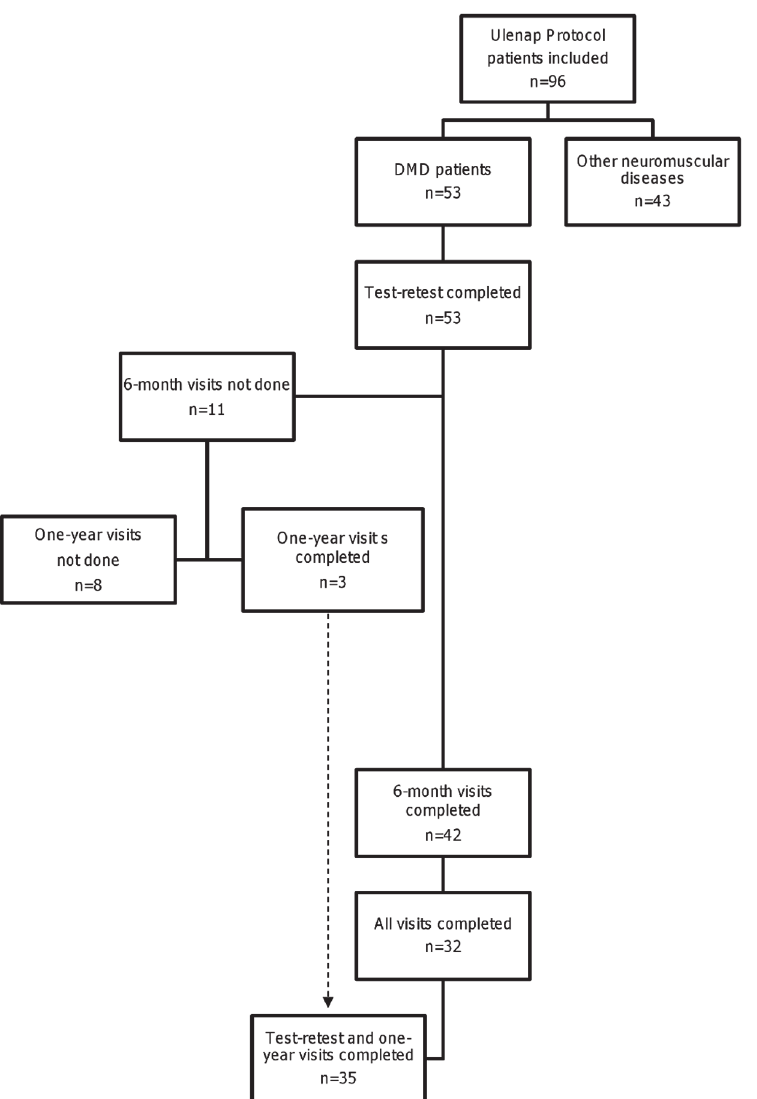
Figure 1. Flow chart of patients included in the clinical